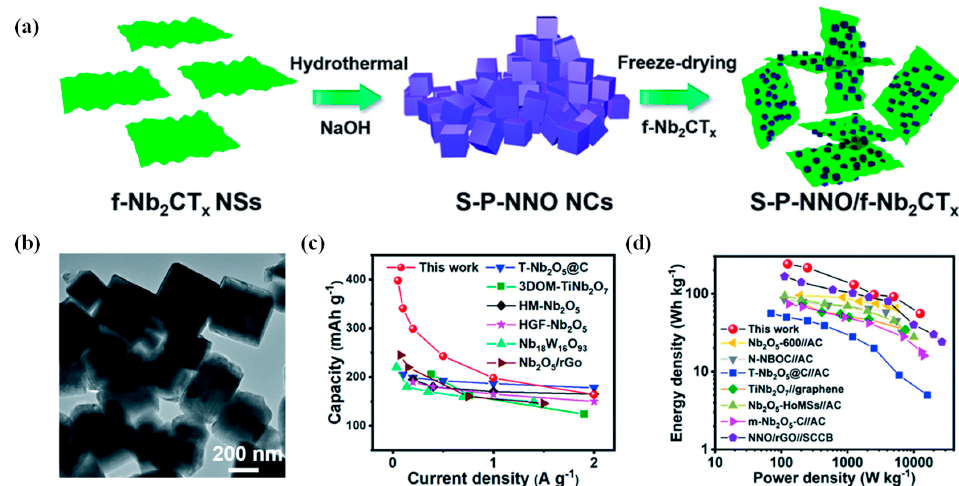
Figure 10. Applications of Nb 2 CT x in hybrid supercapacitors. ( a ) Schematic illustration of the syn- thetic process of the S-P-NNO/f-Nb 2 CT x , ( b ) TEM image of S-P-NNO/f-Nb 2 CT x , ( c ) Rate properties of S-P-NNO/f-Nb 2 CT x and other Nb-based oxide anodes, ( d ) Ragone plots of S- P-NNO/f-Nb 2 CT x for LICs. Copyright Royal Society of Chemistry, 2021 [112].